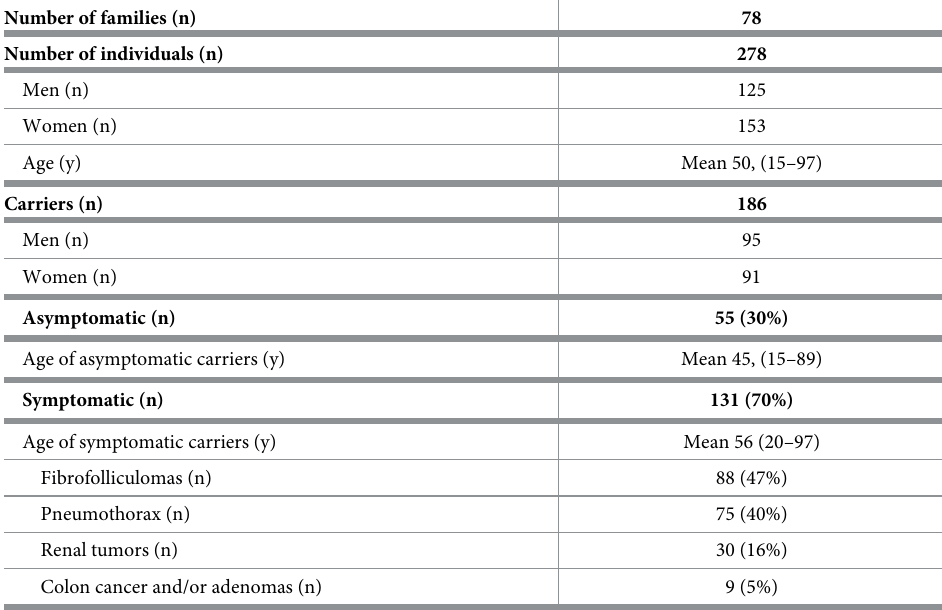
Table 1. Description of included cases in the study.